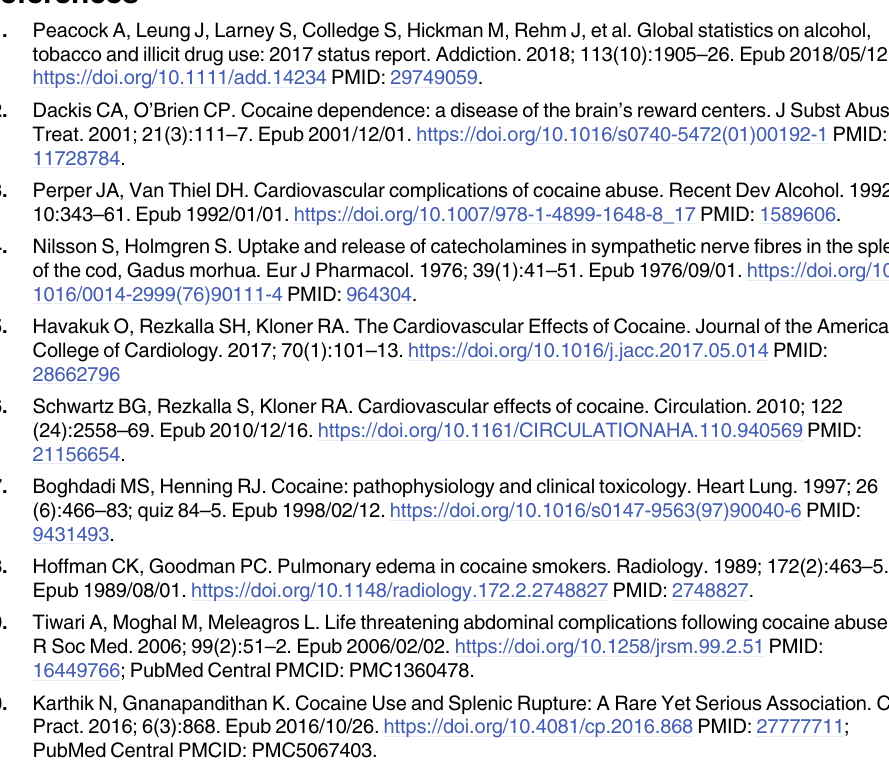
S3 Fig. Repeated administration of cocaine does not affect pyroptosis, necroptosis, and fer- roptosis markers in rat spleen. Immunoblot analysis of phosphorylated-RIP1 (pRIP1), GSDMD, and GPX4 in the spleens of rats administered cocaine. p30 fragment of GSDMD was not observed both in control and cocaine groups. Actin levels were served as internal control. Graphs show the means and S.D. of 6